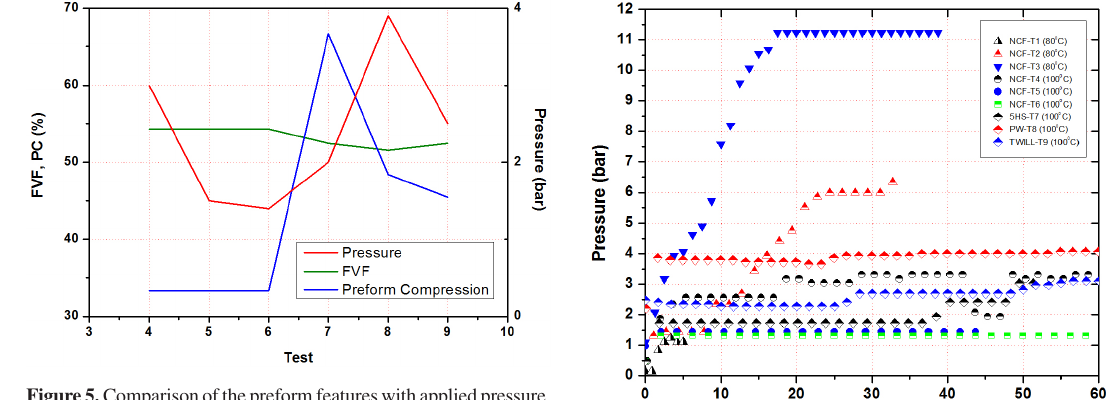
Figure 5. Comparison of the preform features with applied pressure.